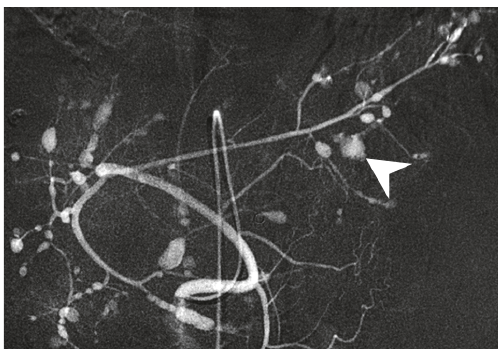
Figure 2: The angiography of abdomen revealed diffuse hepatic artery aneurysms over bilateral liver parenchyma with contrast extravasation over branches of left hepatic artery